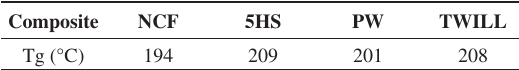
Table 3. Tg values by DMA (tan δ peak).